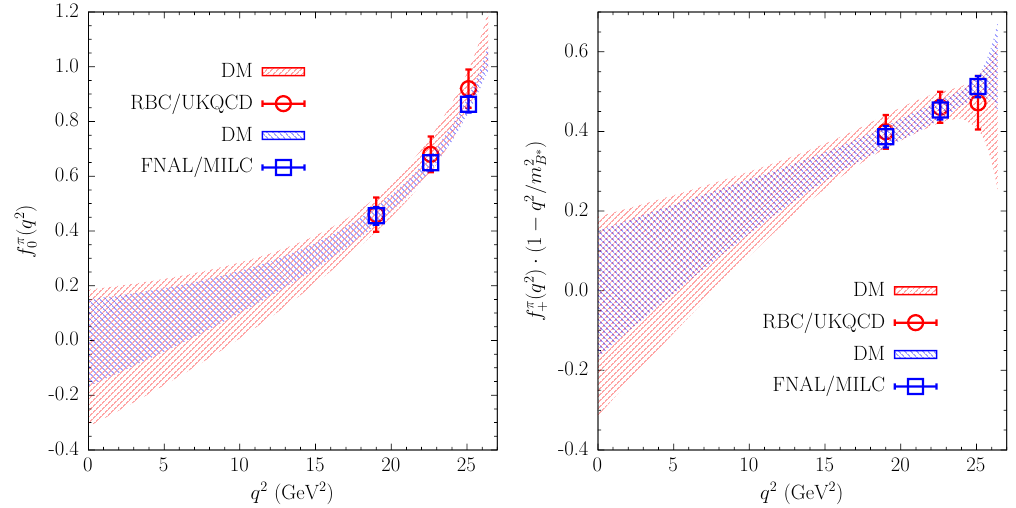
( q 2 ) (left panel) and vector f π ( q 2 ) (right panel) FFs entering the semileptonic Figure 1 . The scalar f π + 0 B → π‘ν ‘ decays computed by the DM method as a function of the 4-momentum transfer q 2 using the LQCD inputs from RBC/UKQCD [20] and FNAL/MILC [21] Collaborations (see table 1). For both FFs the red and blue bands correspond to the DM results obtained at 1 σ level using the RBC/UKQCD data (red circles) and FNAL/MILC (blue squares) data, respectively. In the right panel the vector FF is multiplied by the factor (1 − q 2 /m 2 ) with m = 5 . 325 GeV. . B ∗ B ∗